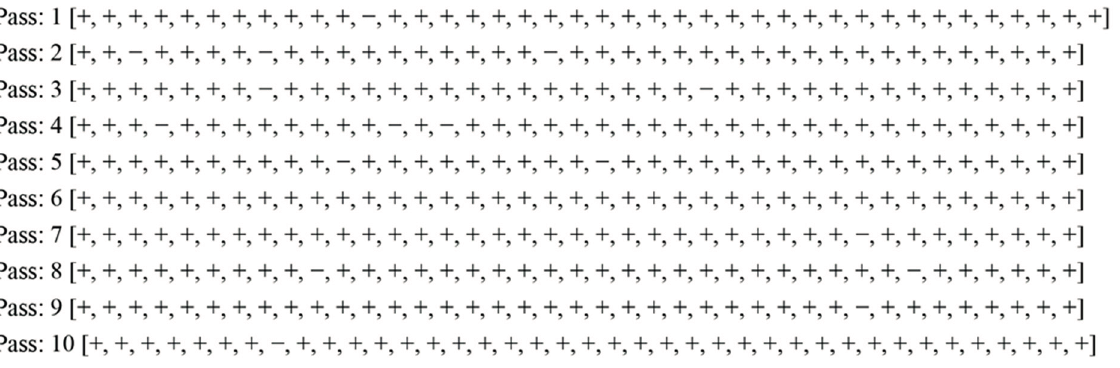
Figure 5. Test results of each pass of the 10-folds cross validation